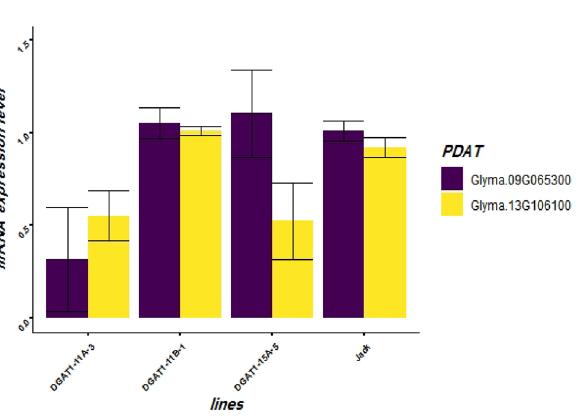
Figure 8. The effect of DGAT1 down-regulation on senescence of transgenic soybean at maturity stage. ( a ) DGAT1-11A-3 (left) and wild type (right). ( b ) DGAT1-15A-5 (left) and wild type (right). ( c ) Spectral reflectance of transgenic lines and wild type. ( d ) Green Normalized Difference Vegetation Index (GNDVI). The presented values are mean ± SE measured using three independent replicates.